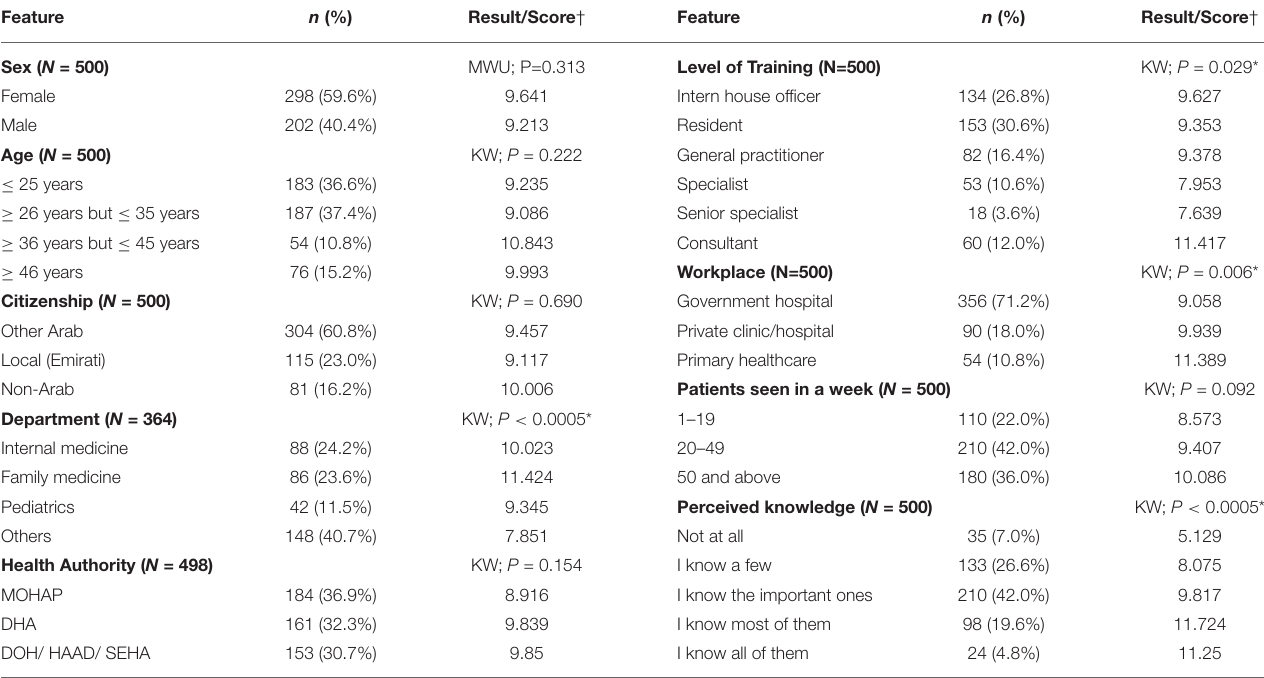
TABLE 3 | Participant demographics, bivariate analyses, and average knowledge for each group.